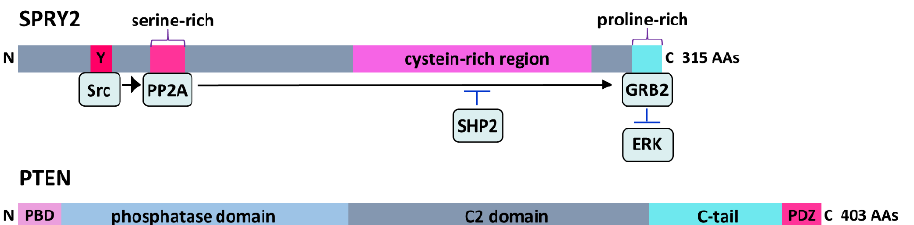
Figure 2. SPRY2 is a 315-amino acid (AA) protein containing a variable N-terminal region with various phosphorylation sites and a highly conserved C-terminal cystein-rich region. RTK stimulation induces tyrosine (Y) phosphorylation in the N-terminus of SPRY2 by Src kinase, which serine dephosphorylates SPRY2 by protein phosphatase 2A (PP2A). This results in a conformational change at the C-terminal proline-rich binding site for growth factor receptor-bound protein 2 (GRB2), thereby preventing the interaction of GRB2 with son of sevenless (SOS) and subsequent ERK activation, while its dephosphorylation by Src homology 2-containing phosphotyrosine phos- phatase (SHP2) dissociates it from GRB2. PTEN is a 403-AA enzyme containing the N-terminal phosphatidylinositol 4,5-bisphosphate (PIP2)-binding domain (PBD), a phosphatase domain, a membrane-targeting C2 domain, a C-terminal tail and a PDZ-binding motif that regulates its stability and subcellular